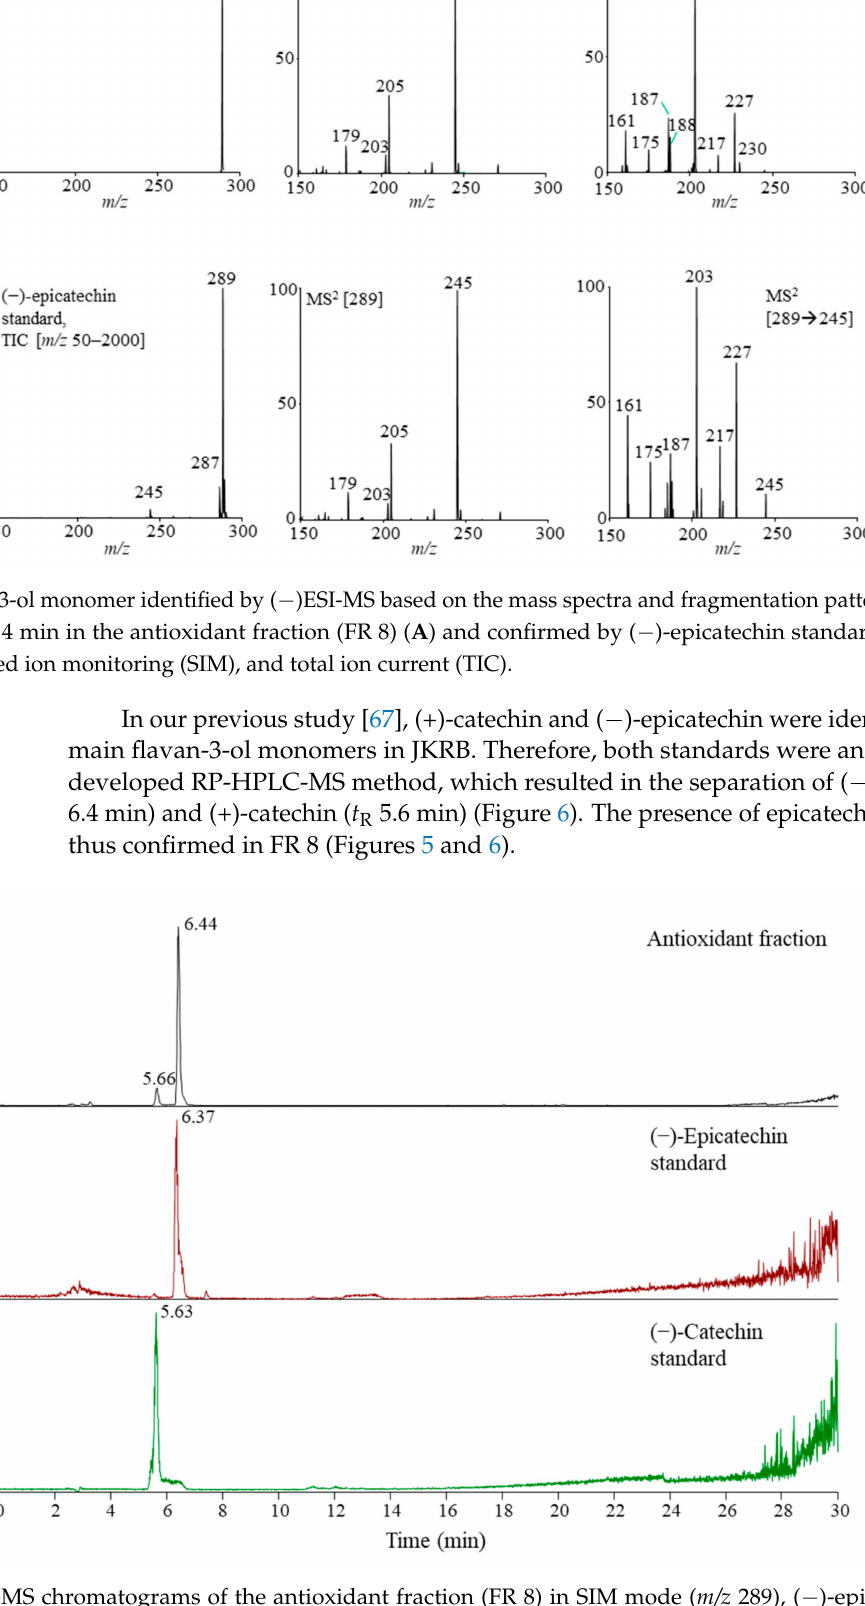
Figure 6. RP-HPLC-MS chromatograms of the antioxidant fraction (FR 8) in SIM mode ( m/z 289), ( − )-epicatechin and (+)-catechin standards (both in TIC mode; m/z